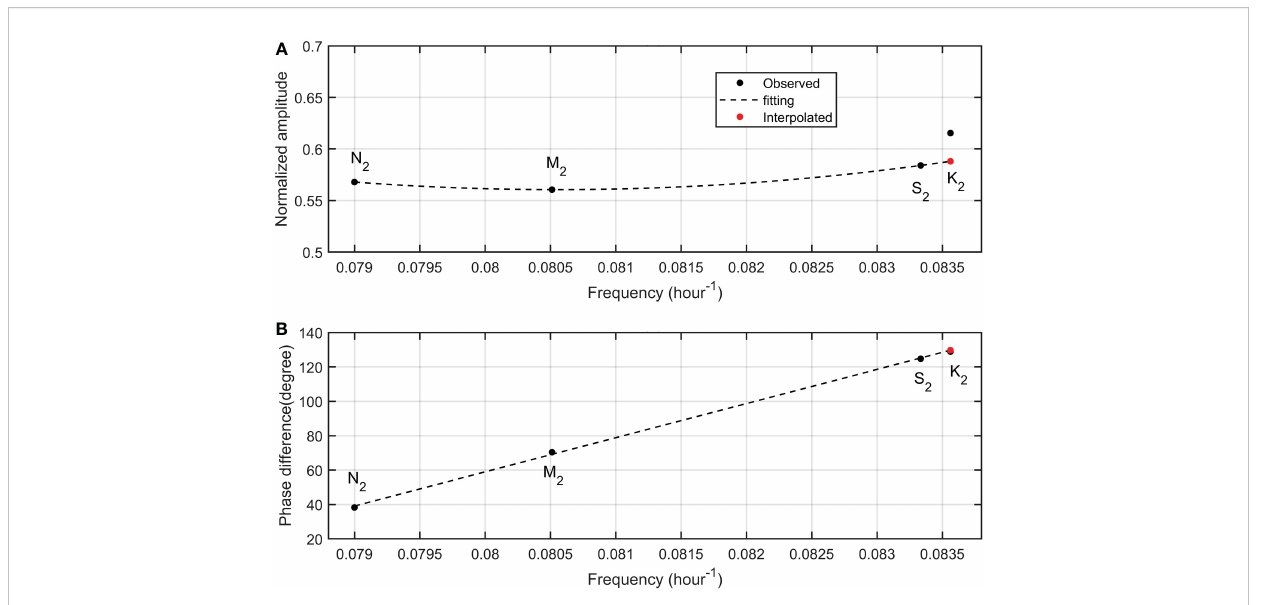
FIGURE 6 Same as Figure 4, but for semi-diurnal